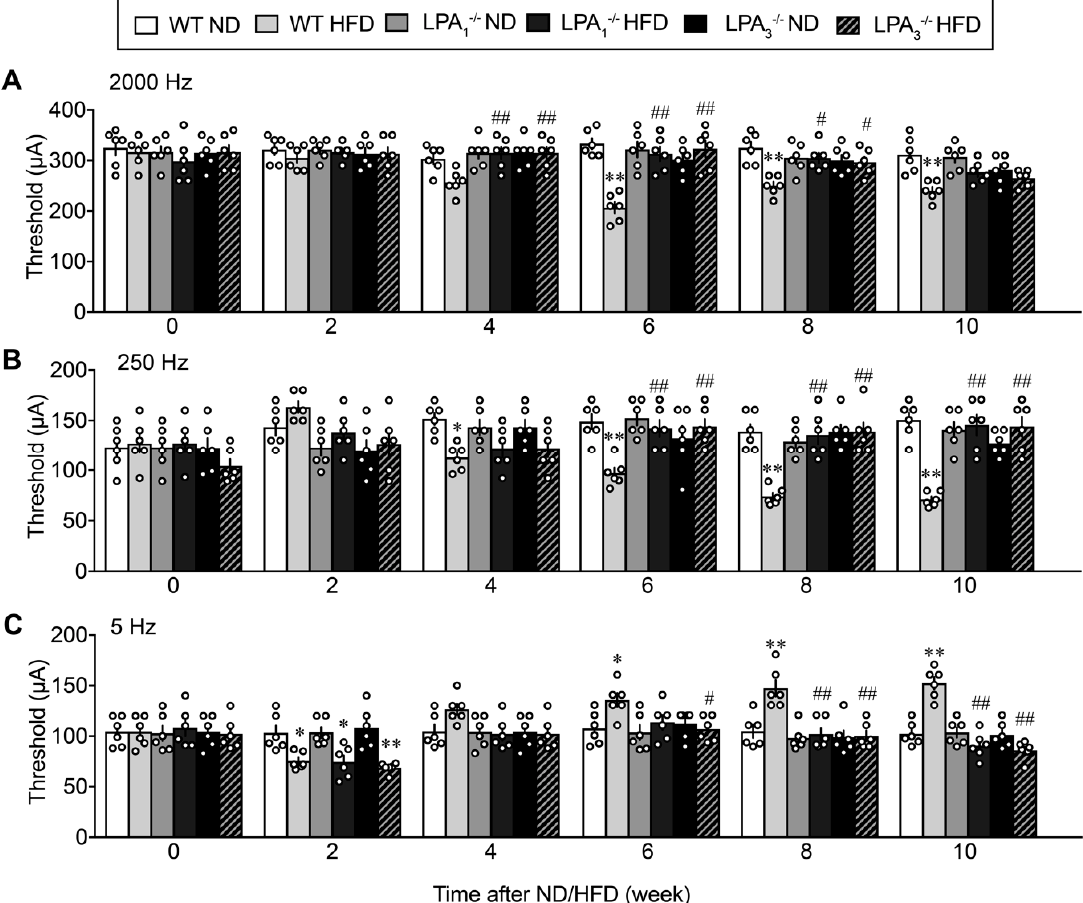
Figure 3. LPA receptor 1 and 3-mediated sensory fiber-specific abnormal pain behaviors in HFD model. ( A – C ) Time course of abnormal pain behaviors with EPW test in WT, LPA 1 − / − and LPA 3 − / − mice